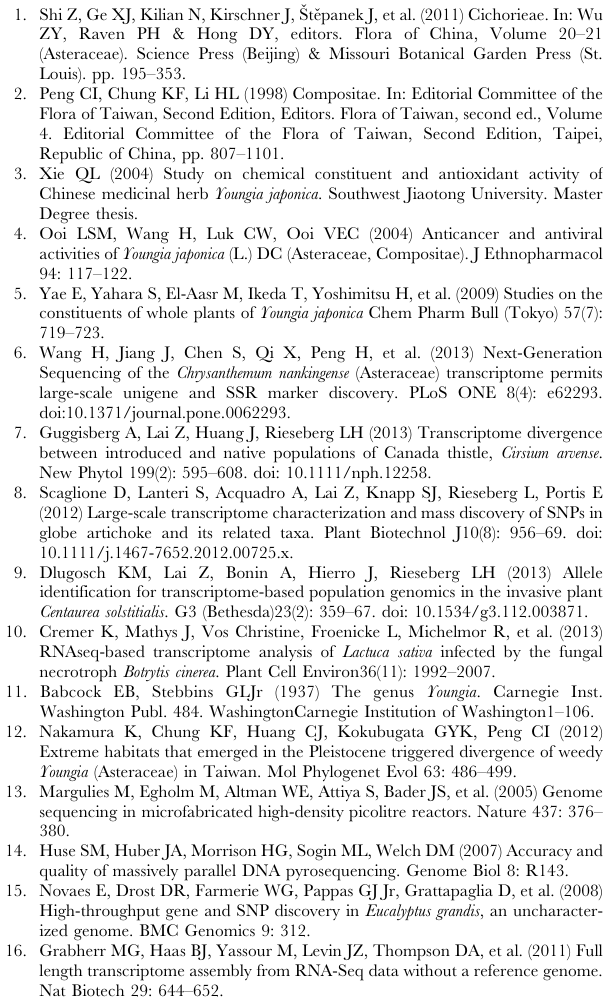
Table S3 Unigenes related to plant hormone signal